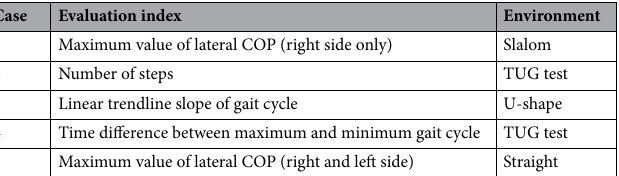
Table 3. Participant evaluation indices and experimental environments. COP center of pressure, TUG timed up and go.